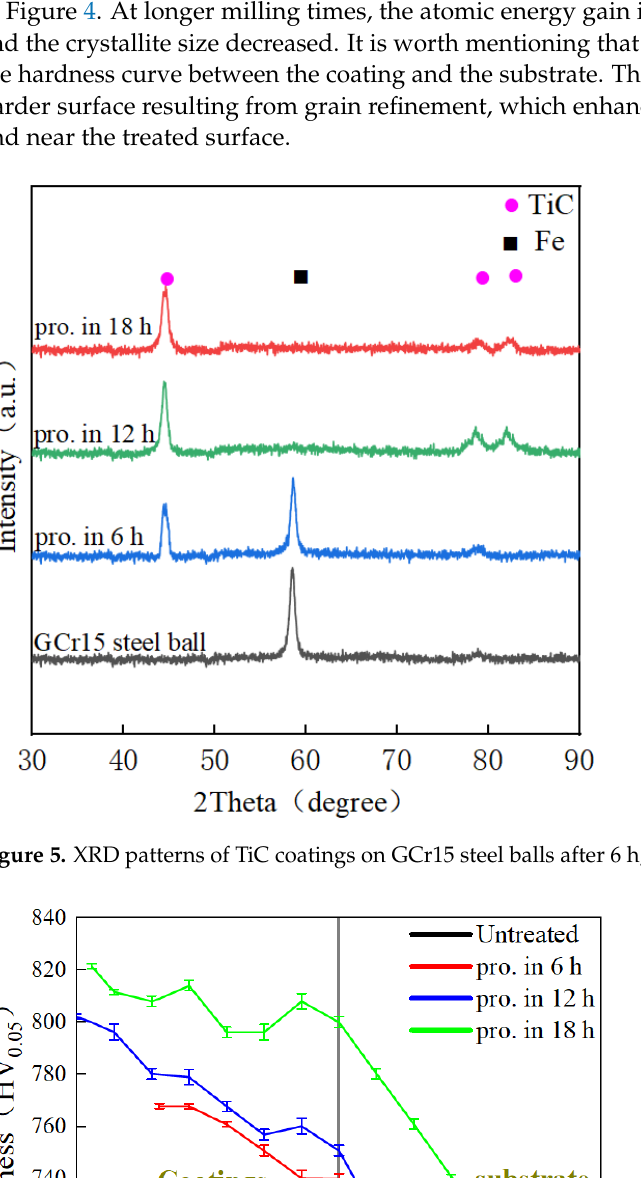
Figure 5. XRD patterns of TiC coatings on GCr15 steel balls after 6 h, 12 h and 18 h milling durations.